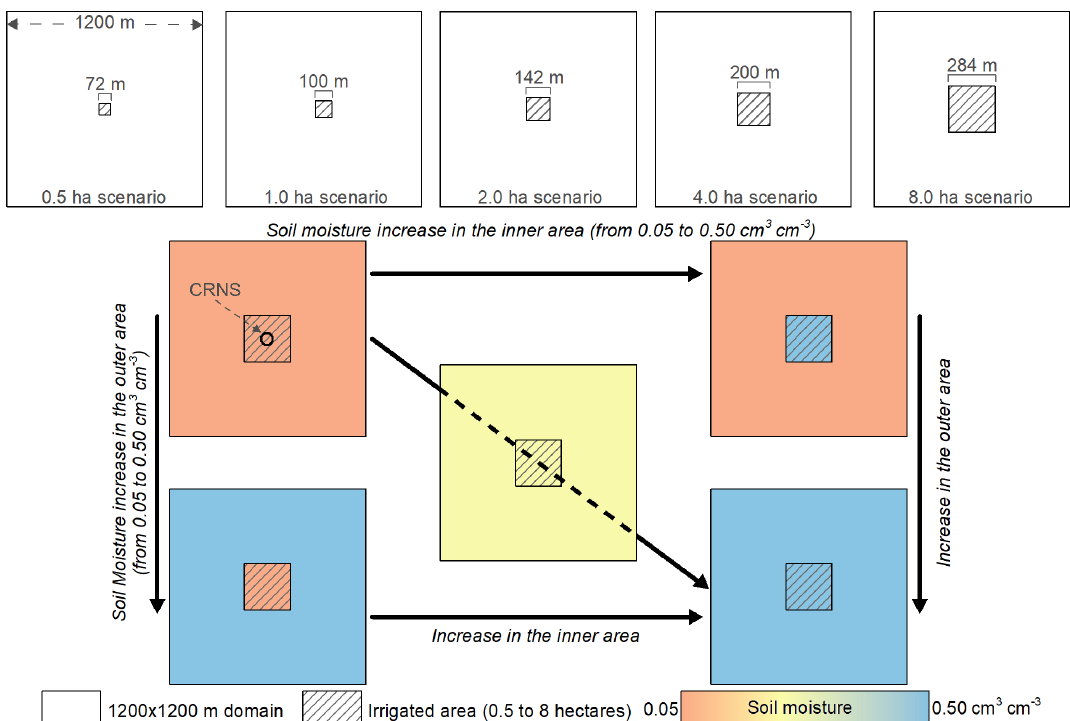
Figure 1. Examples of the dimensions of the inner area relative to the simulation domain and schematization of the simulation design and set-up with an example for the 8ha scenario. A 1200 × 1200m domain is used with an inner area of 8ha and a CRNS placed at its centre. The SM is then systematically varied in the inner and outer area with increments of 0.05cm 3 cm − 3 for a total of 100 simulations.